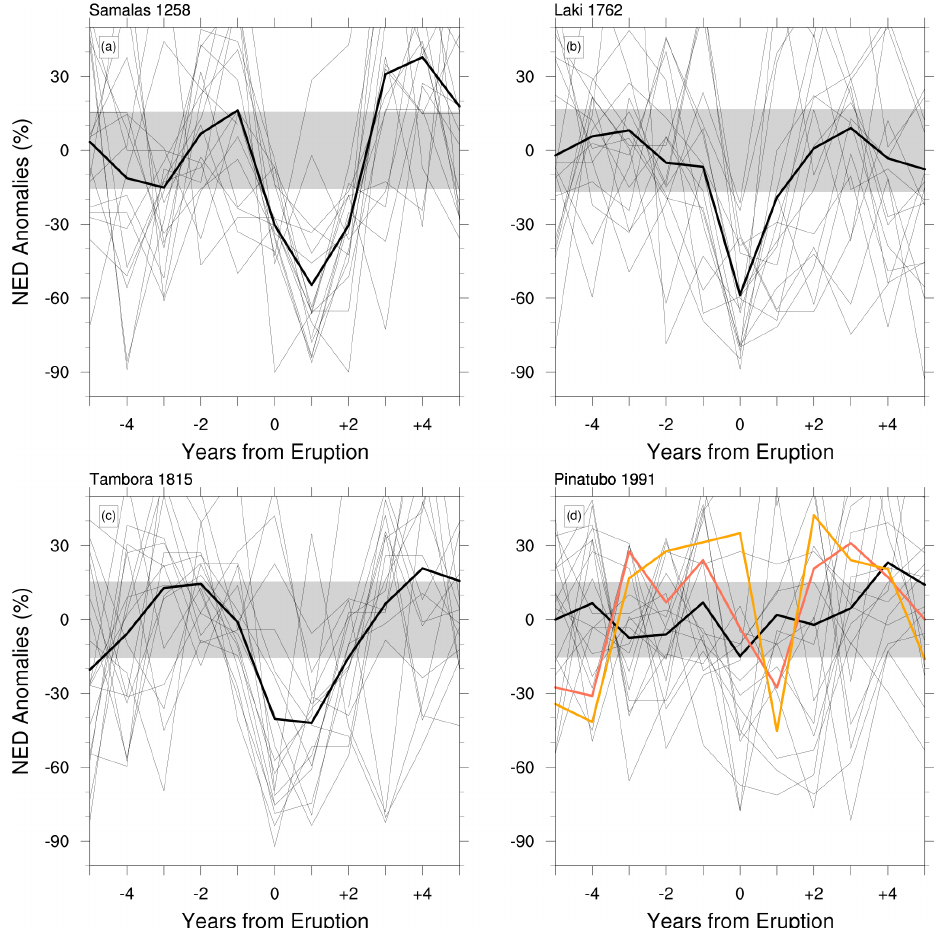
Figure 3. Percentage anomalies of NED for (a) Samalas, (b) Laki, (c) Tambora and (d) Pinatubo eruptions in CESM-LME (black), 20CR (red) and L-days (orange), from 5 pre-eruption to 5 post-eruption years. Zero denotes the year of eruption as listed in Table 1. Thin black lines show percentage NED anomalies for the 17 individual runs of the CESM-LME ensemble. Grey shading measures the ± 2 standard deviation of pre-eruption ( − 5 to − 1 years) NED in CESM-LME. See Fig. S1 for all eruptions listed in Table 1.